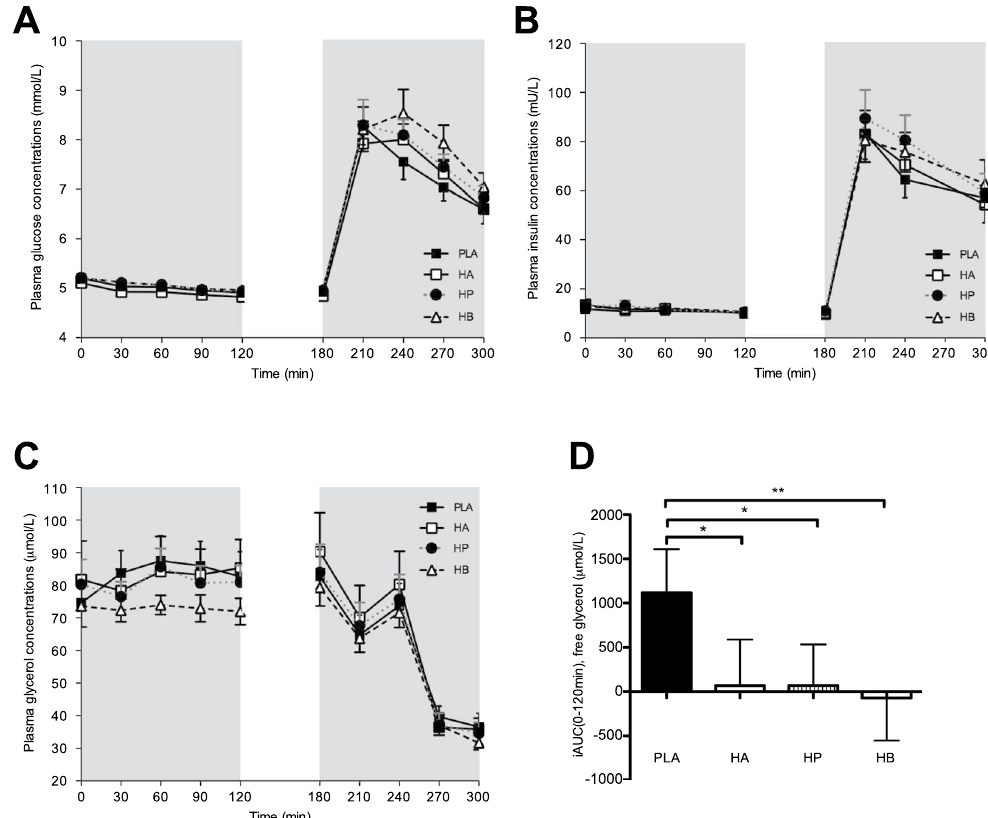
Figure 3. Effect of colonic administration of SCFA mixtures on fasting and postprandial plasma glucose ( A ), insulin ( B ) and free glycerol ( C,D ) concentrations ( A ) Fasting (t0–t120 min) and postprandial (t180–t300 min) plasma glucose concentrations after colonic SCFA infusions. ( B ) Fasting (t0–t120 min) and postprandial (t180–t300 min) plasma insulin concentrations after colonic SCFA infusions. ( C ) Fasting (t0–t120 min) and postprandial (t180–t300 min) plasma free glycerol concentrations after colonic SCFA infusions. ( D ) iAUC for fasting (t0–t120 min) plasma free glycerol following colonic SCFA infusion. Overall treatment effect for free glycerol P = 0.030 (period P = 0.483, carry-over P = 0.832). Values are means ± SEMs (n = 12). Statistical significance indicated as asterisk ( * ) when ** P < 0.01, * P <